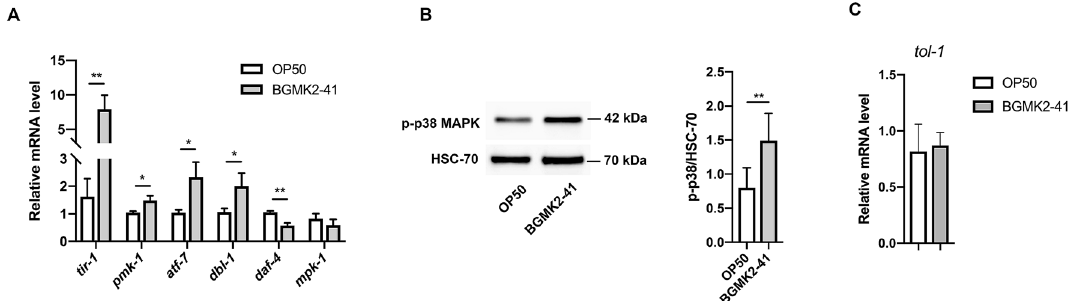
Figure 2. Heat-inactivated Lactobacillus curvatus BGMK2-41 stimulates a canonical p38MAPK immune pathway in C. elegans. ( A ) Expression of immune-related genes measured by qRT-PCR in WT animals after 24 h of treatment with heat-inactivated BGMK2-41 relative to heat-inactivated E. coli OP50 control. ( B ) Representative western blot with densitometric analysis showing the levels of phospho-p38 MAPK